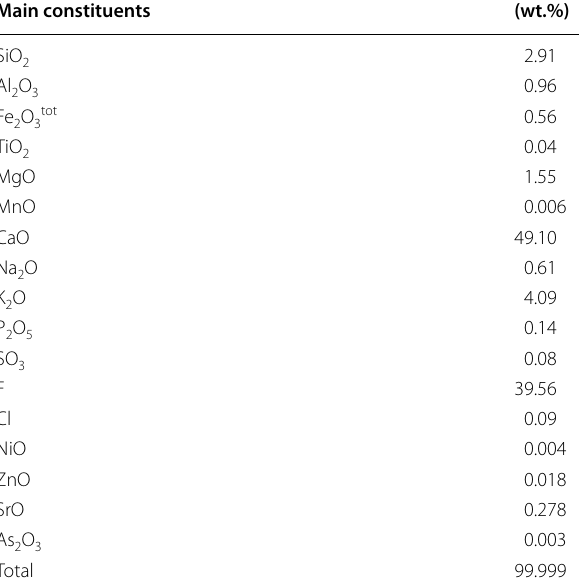
Table 3 XRF results of the